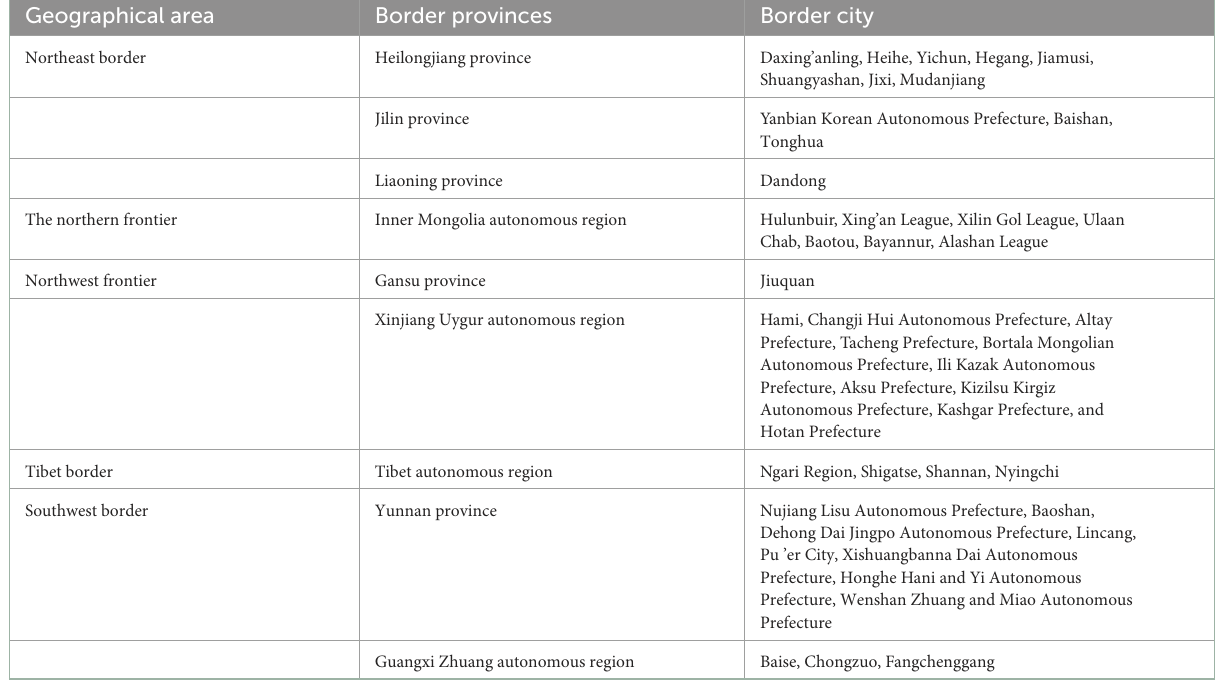
TABLE 1 Geographical divisions of border provinces and cities in China. Geographical